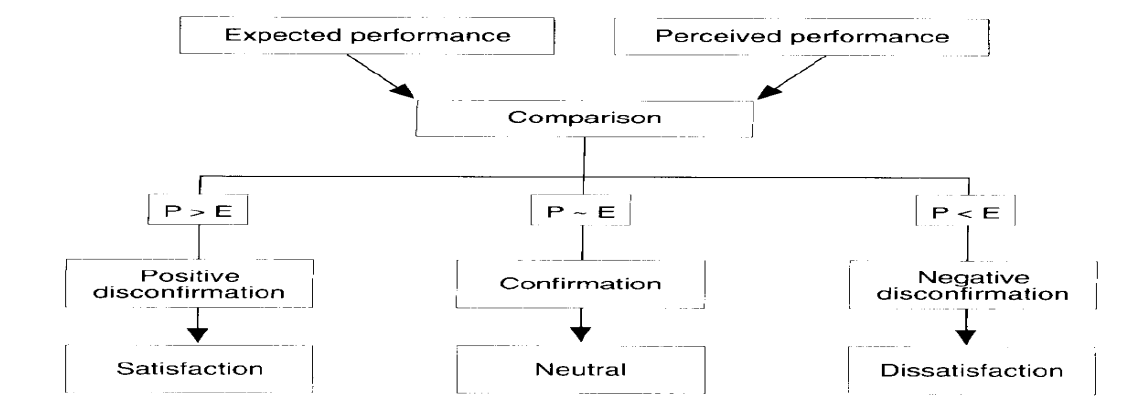
Figure 2: Disconfirmation Theory; Source: Adopted from Szymanski et al.,